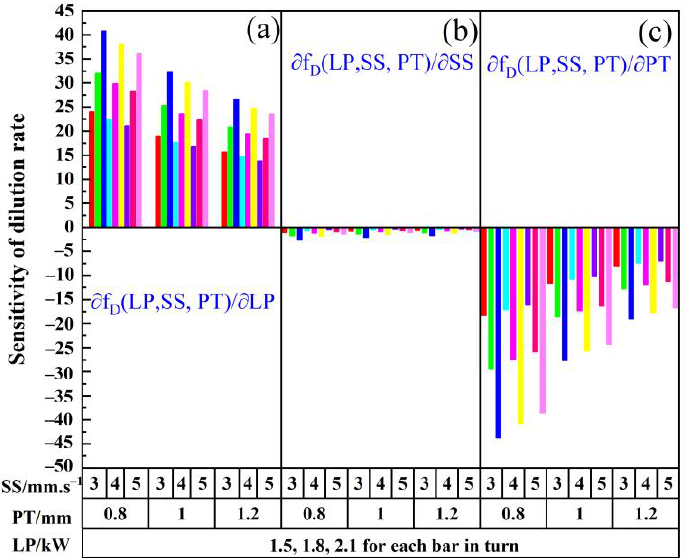
Figure 8. Sensitivity of dilution rate to cladding parameters. ( a ) laser power; ( b ) scanning speed; ( c ) powder thickness.